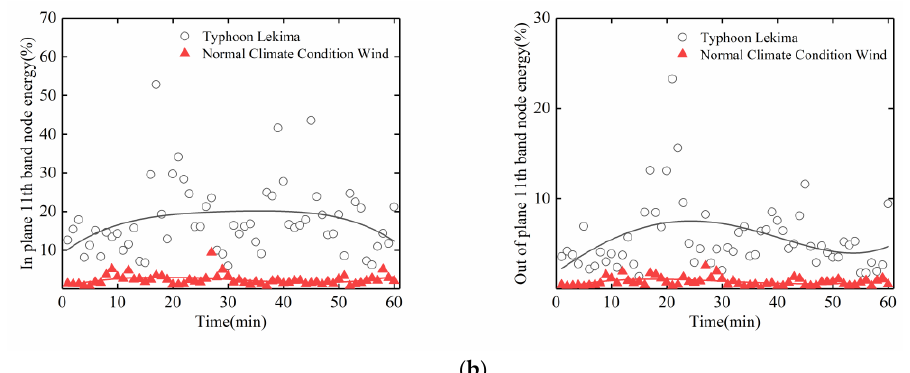
Figure 18. Energy distribution of wavelet packet in the 11th frequency band of the cable: ( a ) Upstream; ( b ) Downstream.